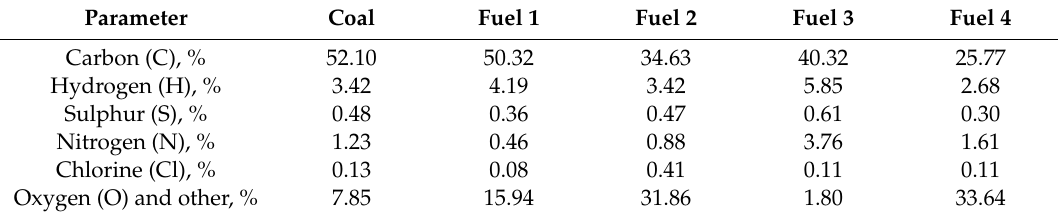
Table 3. The elemental composition of chosen waste fuels and hard coal.